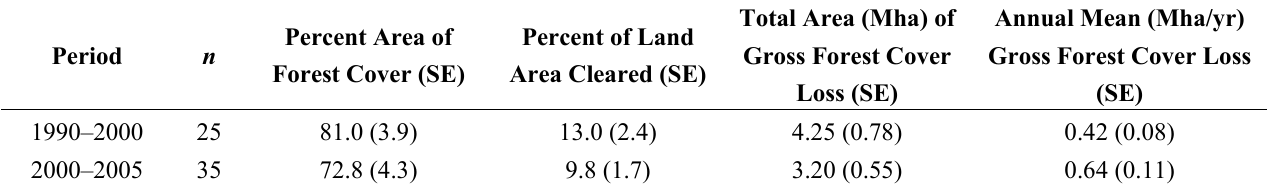
Table 1. Gross forest cover loss estimates for Malaysia: 1990–2000 and